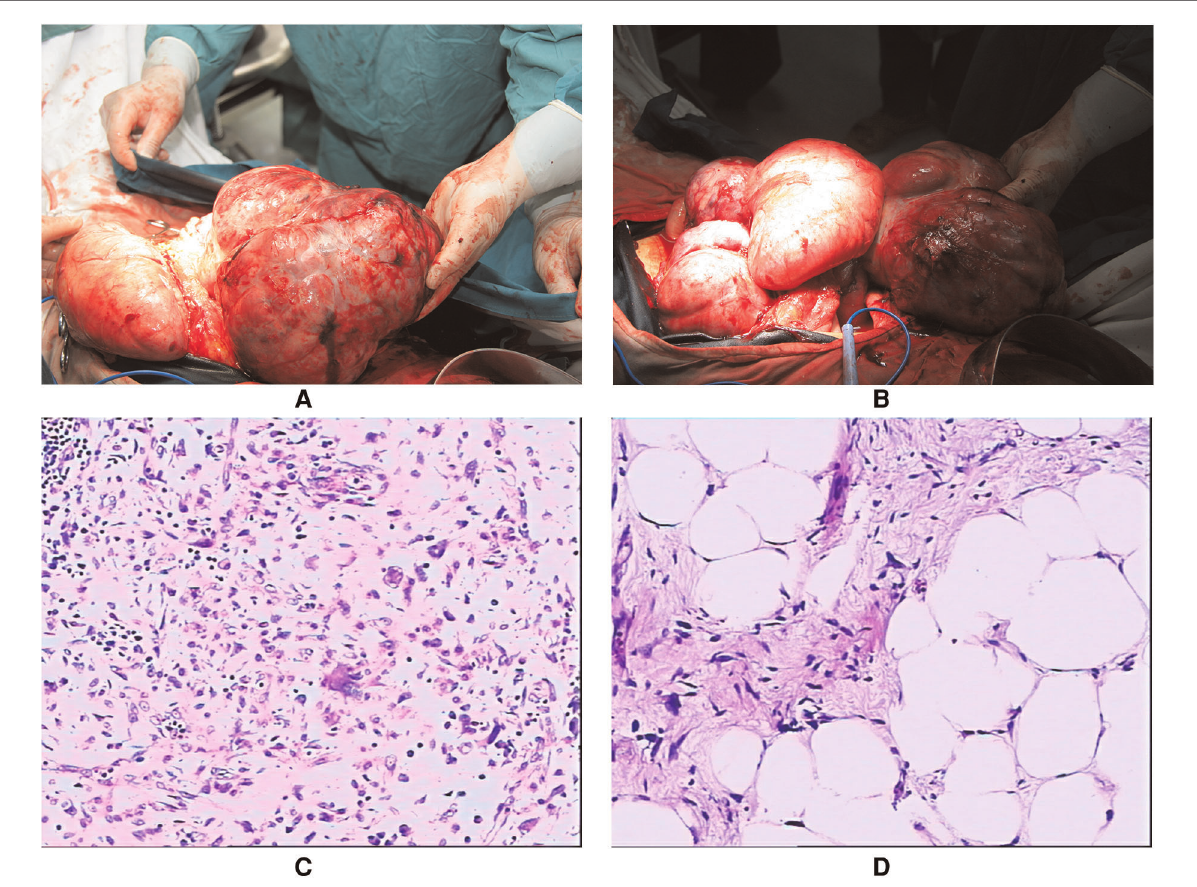
FIGURE 2 The gross appearance of the totally excised tumors presented in the operation (July 2010). ( A ) The giant tumor shaped like lobulated or dumbbell (measured 45×30×20 cm) with rich blood supply; ( B ) The multifocal tumors were well-encapsulated with macroscopic safe margins. The histopathological presentations of the tumors originated from the retroperitoneum and the tumors in fi ltrated the stomach (July 2010). ( C ) The retroperitoneal tumors were diagnosed as dedifferentiated liposarcoma; ( D ) Tumors of the stomach were diagnosed as sclerosing liposarcoma, dedifferentiation in focal